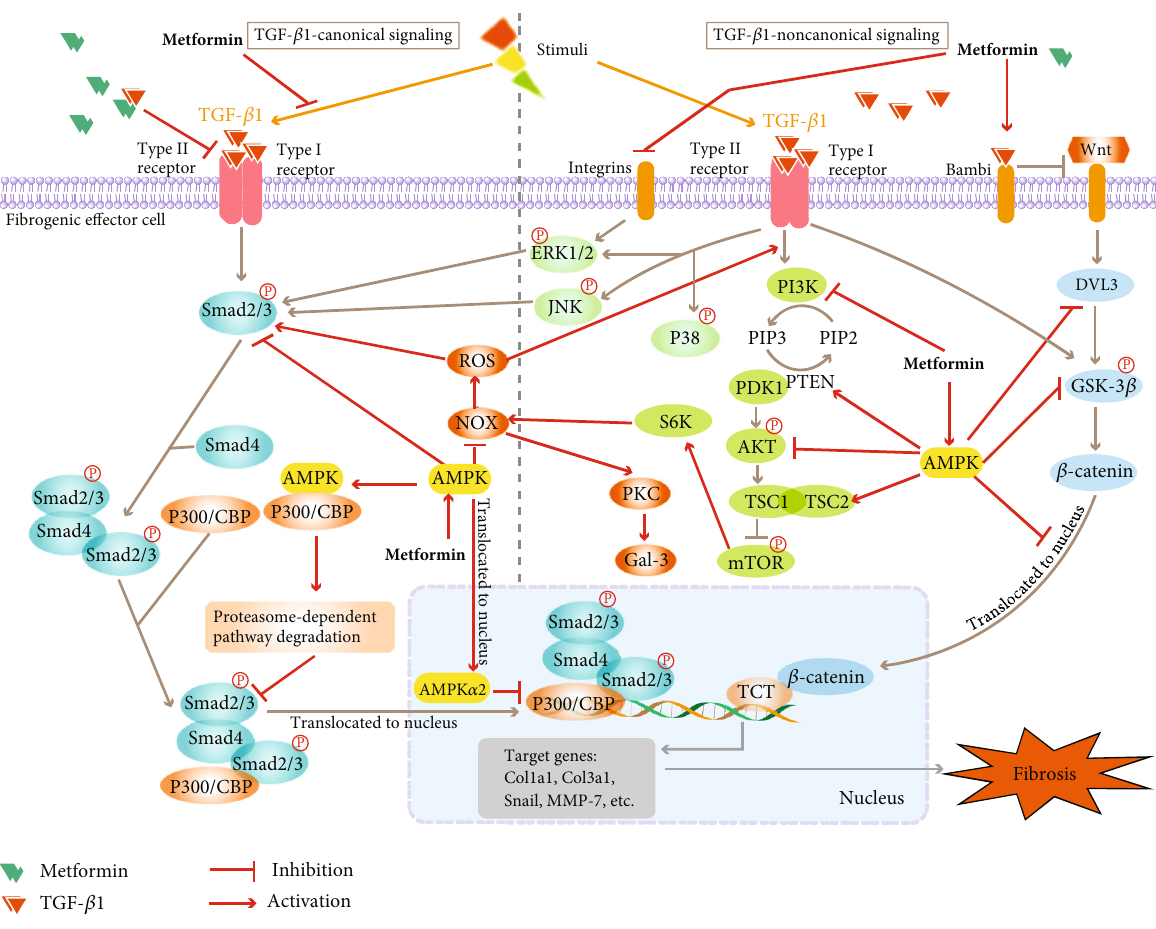
Figure 2: The canonical and noncanonical TGF- β 1 signaling pathways in metformin-mediated anti fi brotic e ff